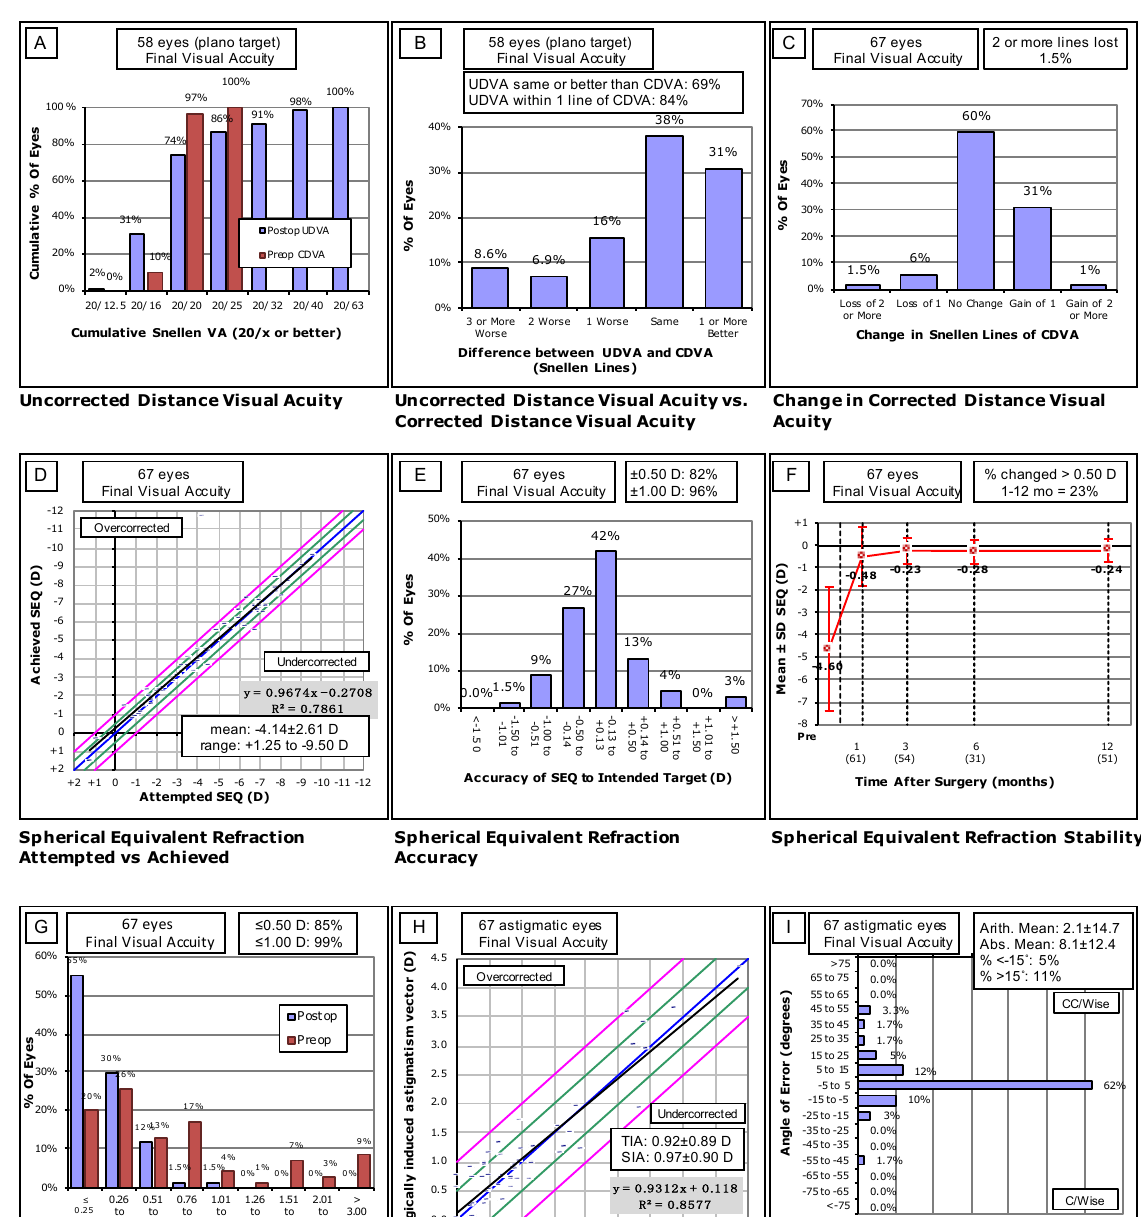
y = 0.9312x + 0.118 R² = 0.8577 0.0 0.5 1.0 1.5 2.0 2.5 3.0 3.5 4.0 4.5